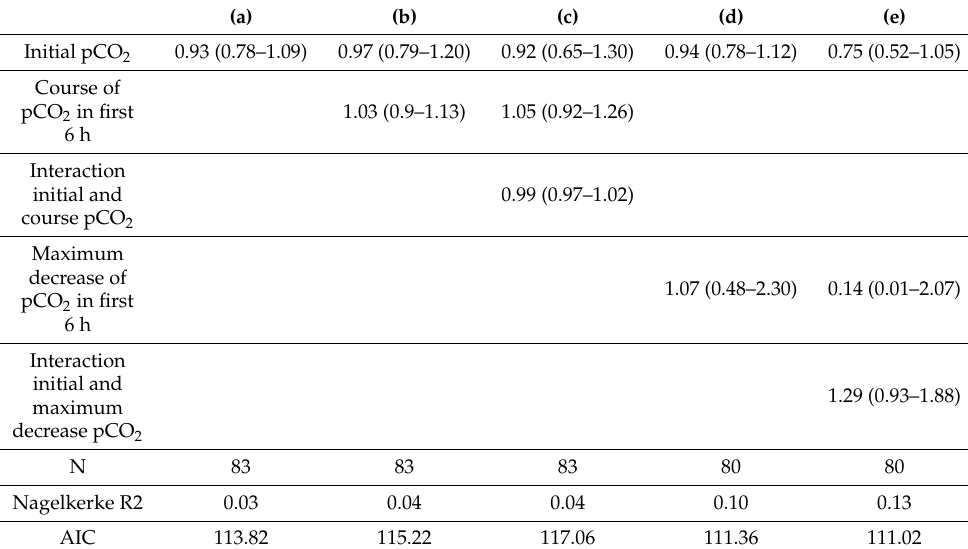
Table 2. Binary logistic regression analysis of ECPR patients regarding pCO 2 measurements and the recovery of